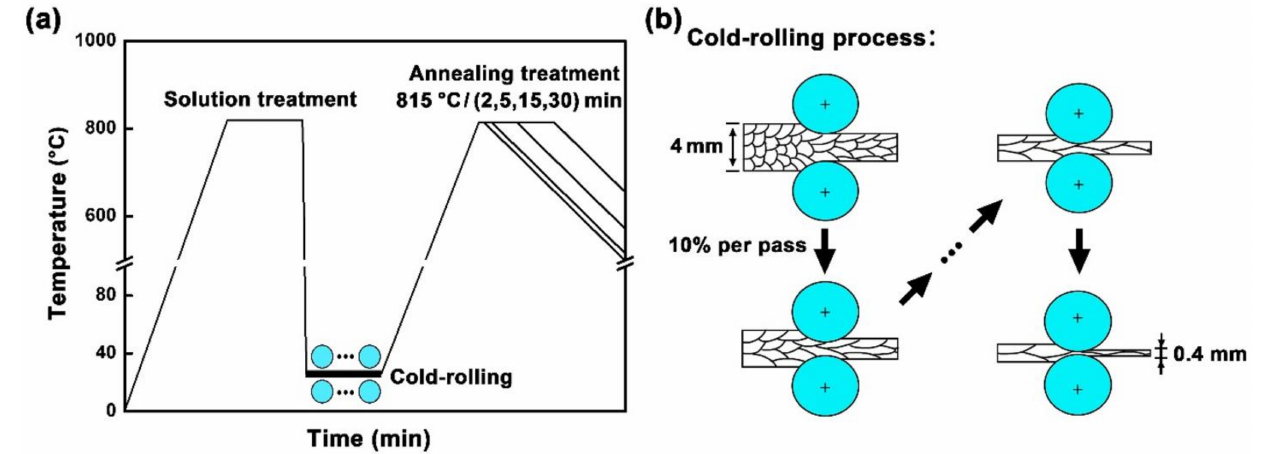
Figure 1. The working process and schematic diagram of cold-rolling: ( a ) the working process; ( b ) cold-rolling